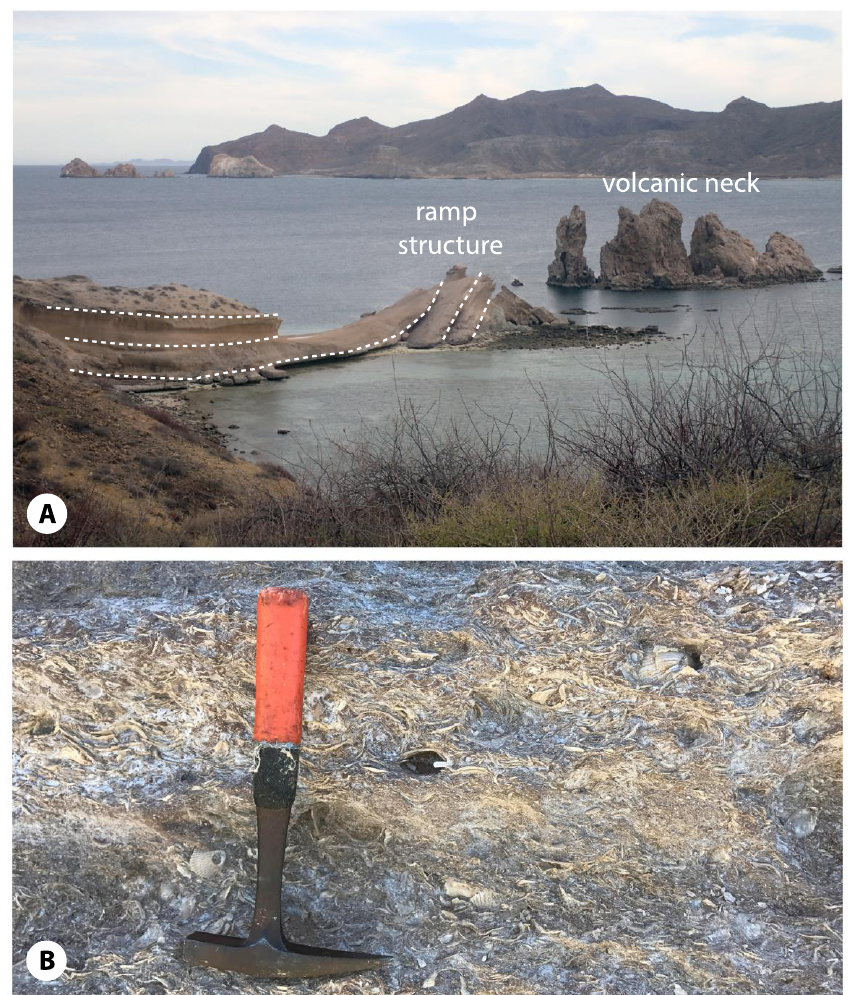
Figure 8. Rock formations below the Spanish Contessa’s house on the north shore of Ensenada San Basilio: ( A ) View southeast showing rhyolite spires in the far distance at Punta Mencenares (upper left), more rhyolite spires in the middle ground (right), and a carbonate bridge pointed southward through up-turned layers toward the adjacent volcanic spires (lower left), ( B ) Densely packed pecten-shell coquinas from bottom of north-dipping ramp (see Appendix 1, Unit 4) with rock hammer for scale.